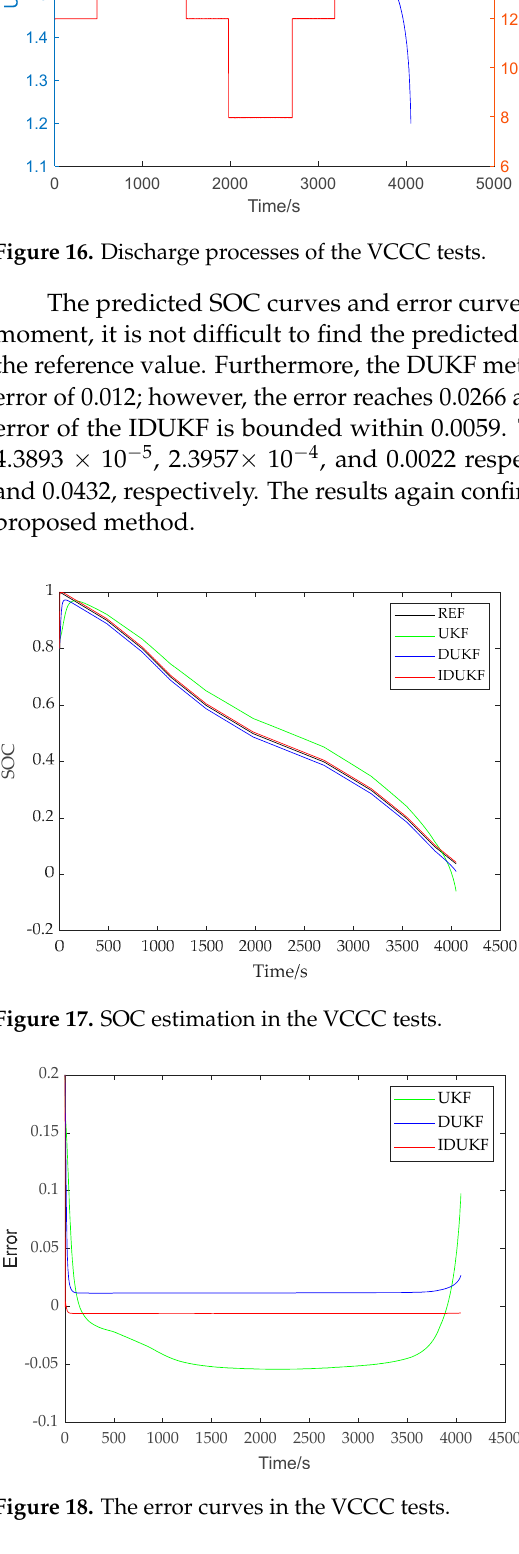
Figure 15. The error curves in the CCPC tests.